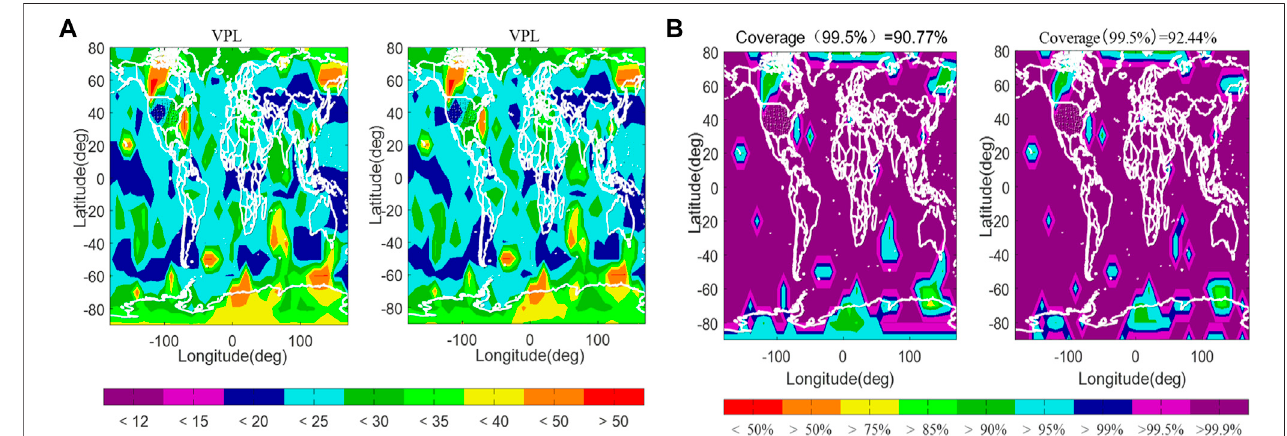
FIGURE 1 | Global VPL and ARAIM global availability under the fi rst set of parameters. (A) Global VPL corresponding to the two allocation methods under the fi rst set of parameters. (B) Global availability of ARAIM corresponding to the two allocation methods under the fi rst set of parameters.